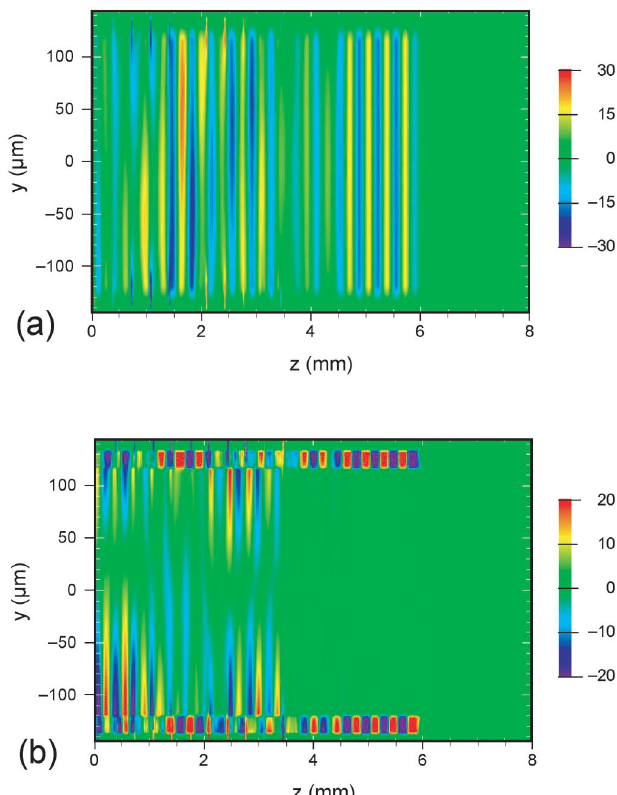
FIG. 3. (Color) False-color plots (from OOPIC simulation) of wakefields behind an infinitely wide electron beam passing through a slab-symmetric structure with an array of coupling slots extending the length of the structure. Structure dimensions are as given in the right-hand column of Table I; the (cold) (cid:1) 100 (cid:2) m , (cid:4) (cid:1) 30 (cid:2) m , is located at z (cid:1) electron beam has (cid:4) z r 5 : 8 mm and is moving in the (cid:3) z direction. (a) Longitudinal (cid:2) cB ), in kV = m . (b) Transverse wakefields, E , wakefields ( E z y z in kV = m . Note that wakefields within the dielectric are saturated; they are generally at least an order of magnitude larger than those in the vacuum